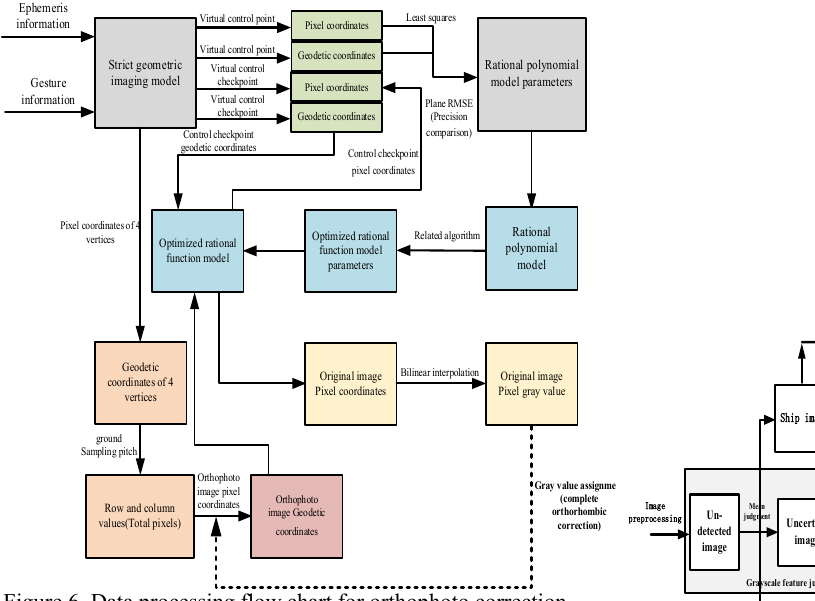
Figure 6. Data processing flow chart for orthophoto correction without ground control point